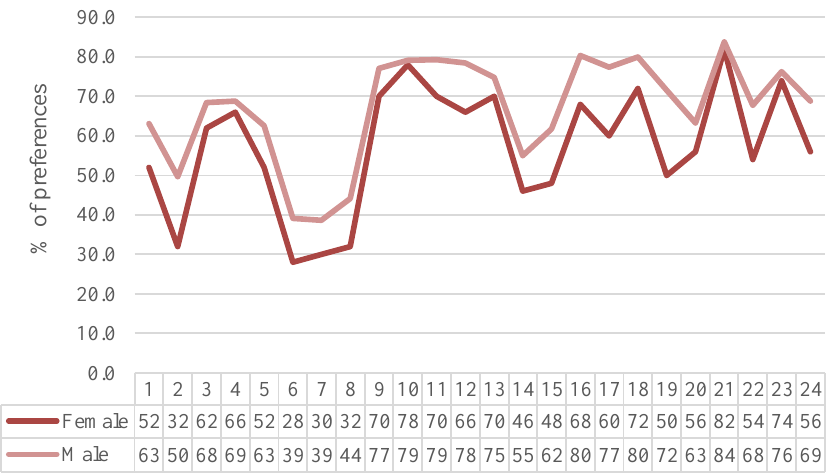
Fig. 1. Percentage of preferences of the different items related to universtity teachers' attitudes and perceptions of EOL by